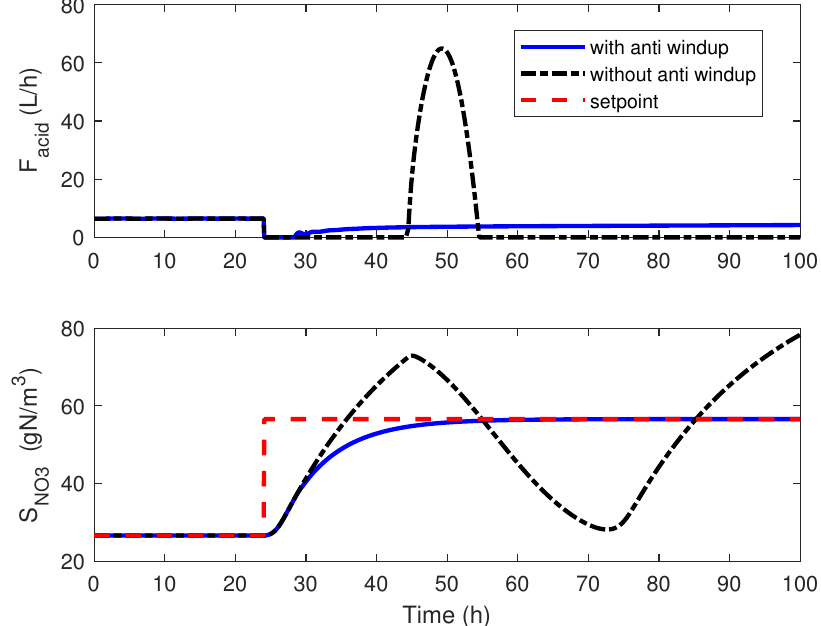
Figure 6. Application of the PI controller with and without anti-windup following a nitrate setpoint variation. A K aw value of 1 is −